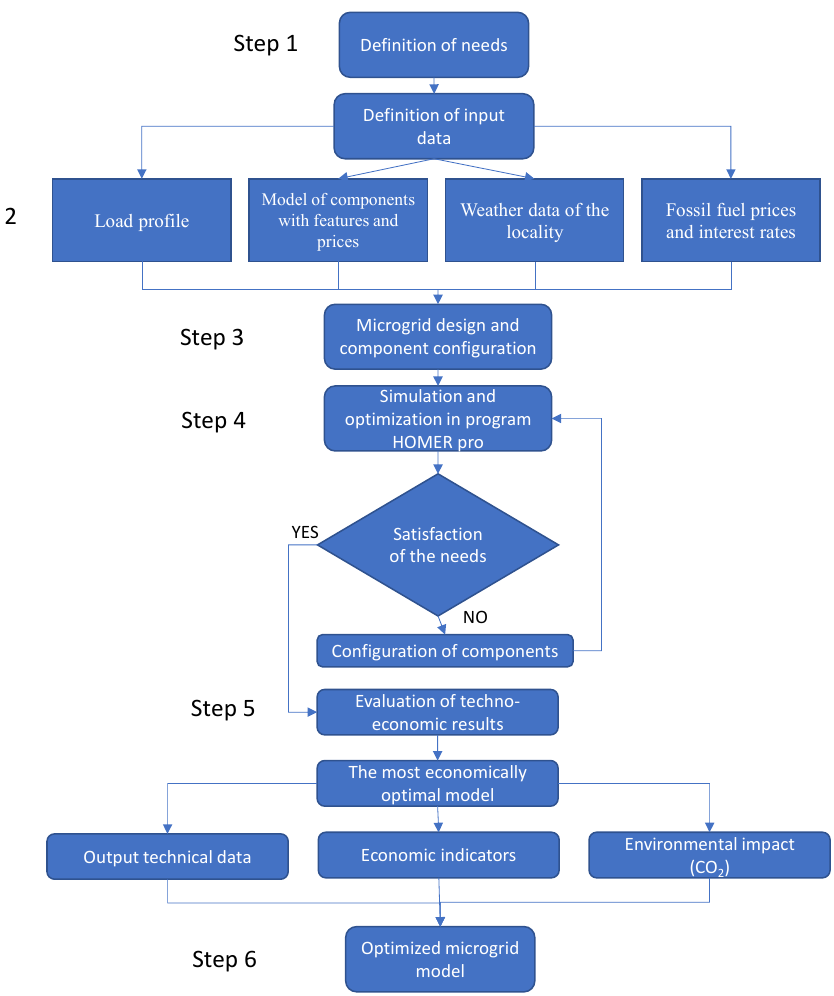
Figure 1. Graphic representation of methodology with flow diagram.